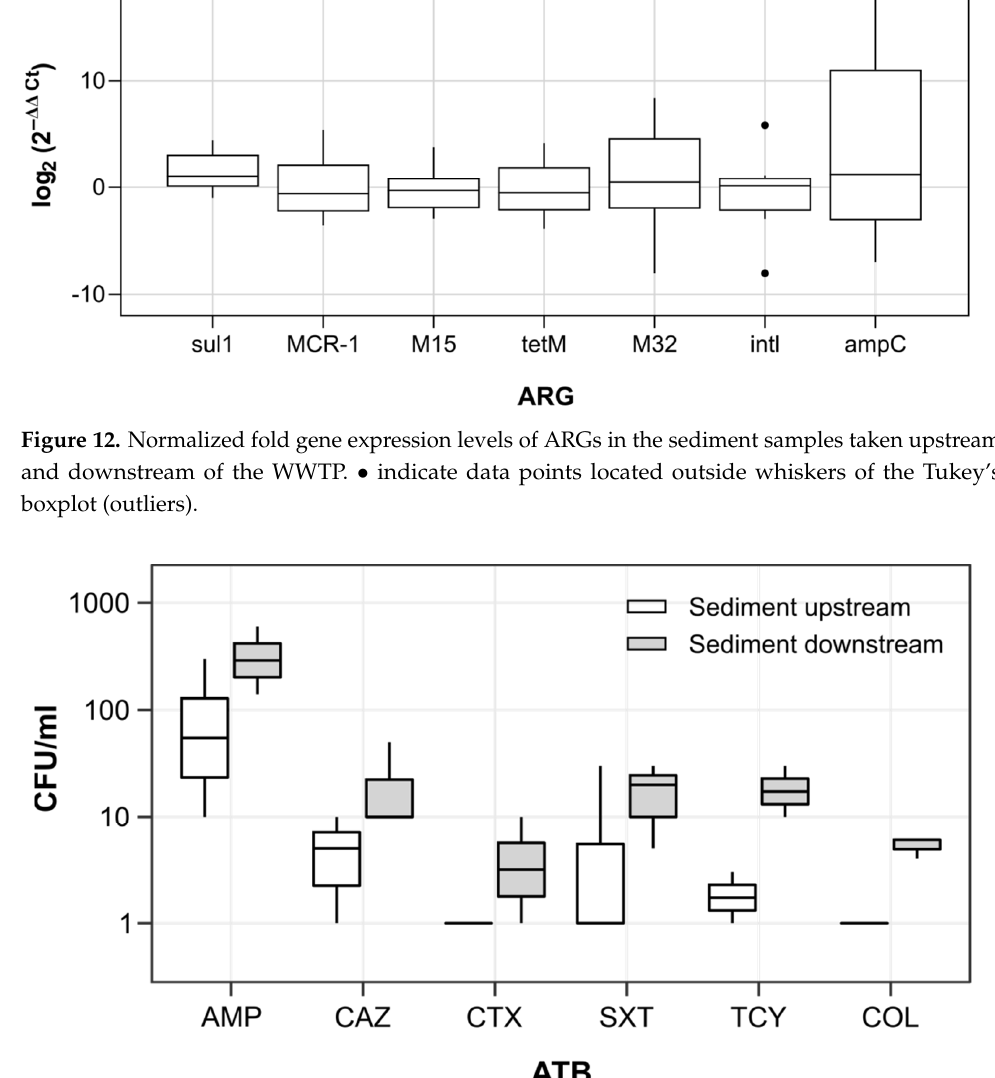
Figure 13. Box plots of the abundance of culturable Escherichia coli resistant to ampicillin (AMP), ceftazidime (CAZ), cefotaxime (CTX), sulfamethoxazole (SXT), tetracycline (TCY) and colistin (COL) measured in the river sediments.